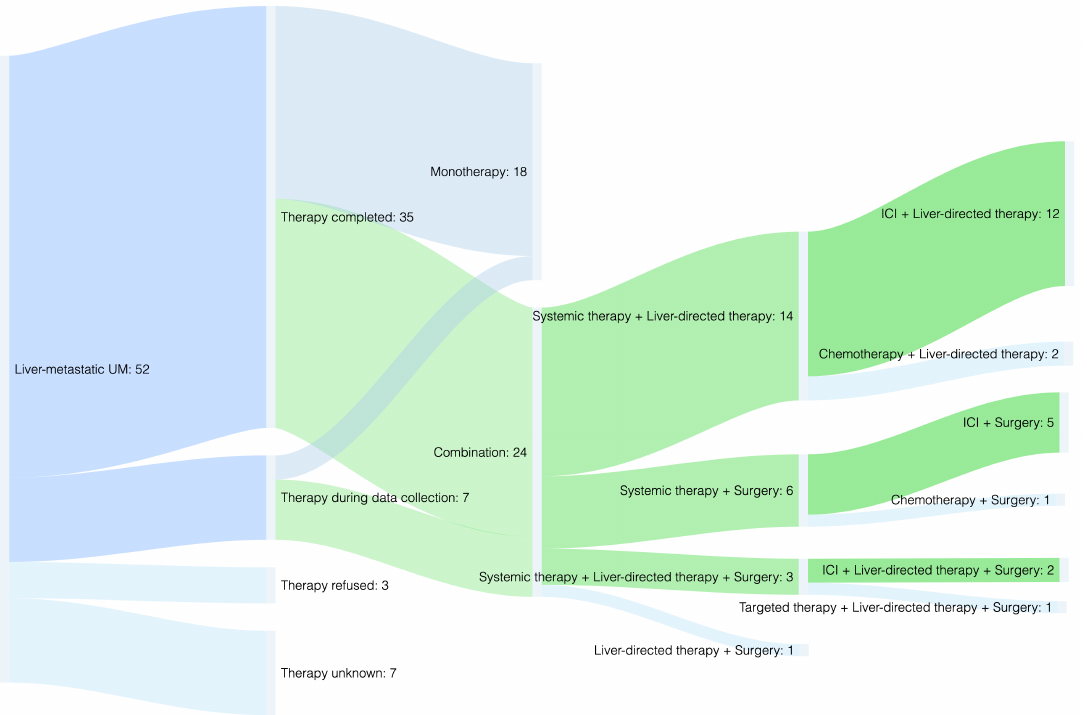
Figure 1. Therapy regimens. Note: the green path illustrates Cohort 1 including all patients treated with ICI plus liver- specific therapies (surgical resection of metastases and/or liver-directed therapies such as transarterial chemoembolization), which was compared to Cohort 2 (blue path, including any other therapy modalities, such as any monotherapies or any other combination therapies). For a detailed overview about the different therapies performed, see Table